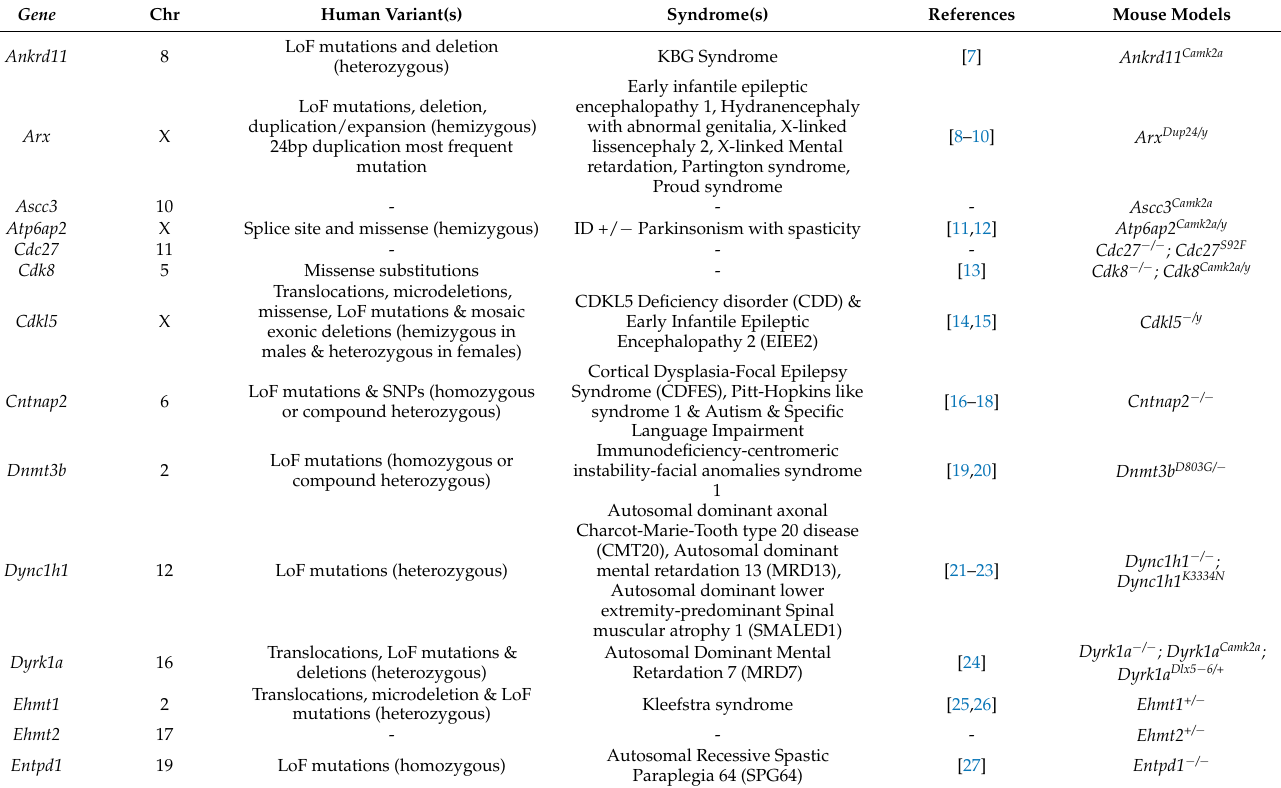
Table 1. List of mutated genes, human variants, their functional implication in human syndromes, and mouse models generated in this study for these genes. LoF and GoF indicate loss-of-function and gain-of-function, respectively. SNPs indicate Single Nucleotide